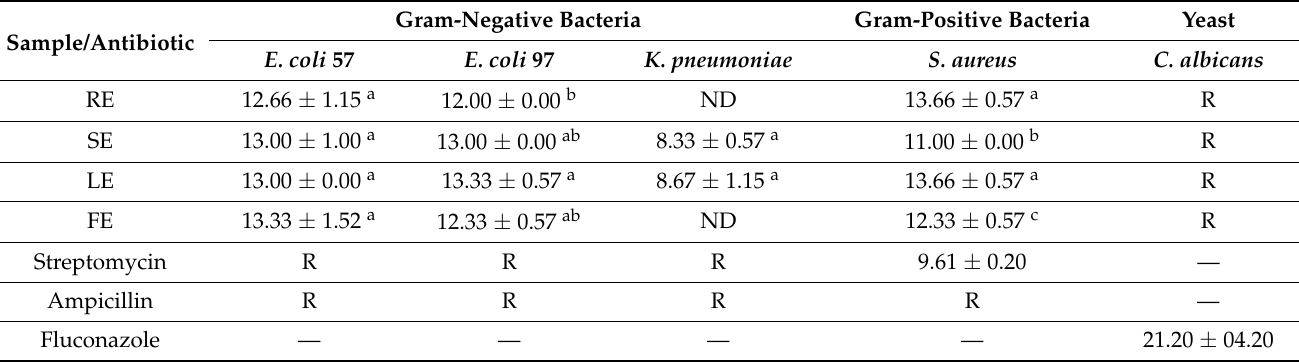
Table 3. Diameter of the inhibition zone of P. rhoeas extracts and antibiotics (mm).